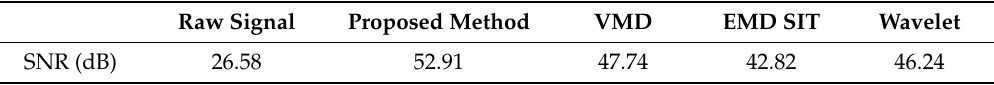
Table 2. SNR comparison with classic o ff -line denoising methods.